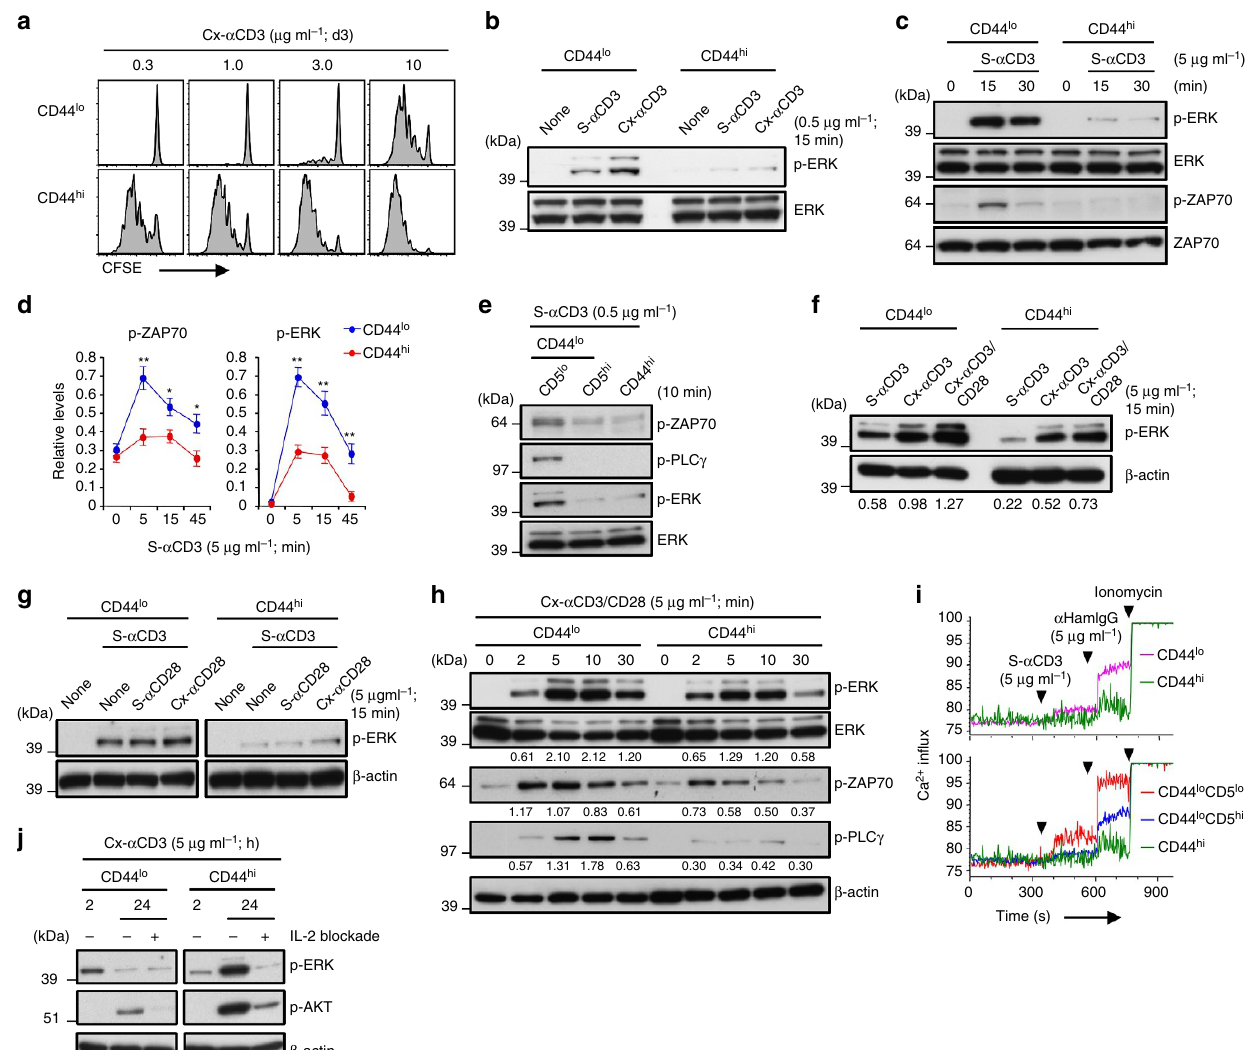
Figure 2 | TCR sensitivity of na ı¨ ve versus memory CD8 þ Tcells. ( a ) Proliferation of CFSE-labelled CD44 lo naı¨ve and CD44 hi memory-phenotype (MP) B6 CD8 þ Tcells after incubation with Cx- a CD3 mAb. ( b ) ERK phosphorylation in CD44 lo and CD44 hi B6 CD8 þ Tcells after incubation with S- a CD3 or Cx- a CD3 mAb. ( c , d ) Phosphorylation of ERK and ZAP70 ( c ) and densitometric levels (relative to b -actin; mean ± s.d.) ( d ) in CD44 lo and CD44 hi B6 CD8 þ Tcells after incubation with S- a CD3 mAb. ( e ) Phosphorylation of ERK, ZAP-70, and PLC g in CD44 lo CD5 lo and CD5 hi and CD44 hi B6 CD8 þ Tcells after incubation with S- a CD3 mAb. ( f , g ) ERK phosphorylation in CD44 lo and CD44 hi B6 CD8 þ Tcells after incubation with S- or Cx- a CD3 ± Cx- a CD28 ( f ) and S- a CD3 ± S- or Cx- a CD28 mAbs ( g ). ( h ) Phosphorylation of ERK, ZAP-70, and PLC g in CD44 lo and CD44 hi CD8 þ Tcells after incubation with Cx- a CD3 and - a CD28 mAbs. ( i ) Flow cytometry for Ca 2 þ flux in CD44 lo and CD44 hi (top) or CD44 lo CD5 lo and CD5 hi and CD44 hi CD8 þ Tcells (bottom) gated from Indo-1-loaded total B6 LN cells after incubation with the indicated stimuli. ( j ) Phosphorylation of ERK and AKT in CD44 lo and CD44 hi B6 CD8 þ Tcells at 2 and 24h after incubation with Cx- a CD3 mAb ± a IL-2 mAb blockade. Data are representative of three ( a , b , e – j ) and at least four independent experiments ( c , d ). Unpaired Student’s t -test was used for the statistical analysis. * P o 0.005; ** P o 0.0005. consistent with the above data on p-ERK induction (Fig. 1c–h), this difference was reversed at 24 h: at this time, p-ERK induction CD44 lo CD5 lo cells showed higher Ca 2 þ fluxes than CD5 hi cells in CD44 hi MP cells rose to very high levels and was paralleled by (Fig. 2i, lower and Supplementary Fig. 2i). Consistent with the strong induction of p-AKT (Fig. 2j). Notably, such signalling was role of PLC g in Ca 2 þ signalling 24 , the limited Ca 2 þ flux seen abolished by mAb blockade of IL-2, indicating that the strong with CD3 ligation of CD44 hi MP cells correlated with reduced induction of p-ERK and p-AKT in the cultures at 24 h reflected p-PLC g in these cells relative to CD44 lo naı¨ve cells (Fig. 2e,h). rapid production of IL-2 by the memory cells. For the mitogen-activated protein kinase pathways, weak induction of p-ERK by CD3 ligation in CD44 hi cells could not be overcome by addition of costimulation via CD28 ligation TCR sensitivity of antigen-induced memory CD8 þ T cells . (Fig. 2f,g) and did not apply to p-p38 or p-JNK induction Since MP cells in normal mice are not necessarily the counterpart (Supplementary Fig. 2j). For p-ERK induction, weaker induction of memory cells primed to defined antigens, we examined the in CD44 hi MP cells than CD44 lo naı¨ve CD8 þ T cells was TCR sensitivity of antigen-induced memory CD8 þ T cells. As for apparent from 5 min to 2 h after CD3 stimulation. Surprisingly, the polyclonal CD44 hi cells from B6 mice used above, poor NATURE COMMUNICATIONS|7:13373|DOI: